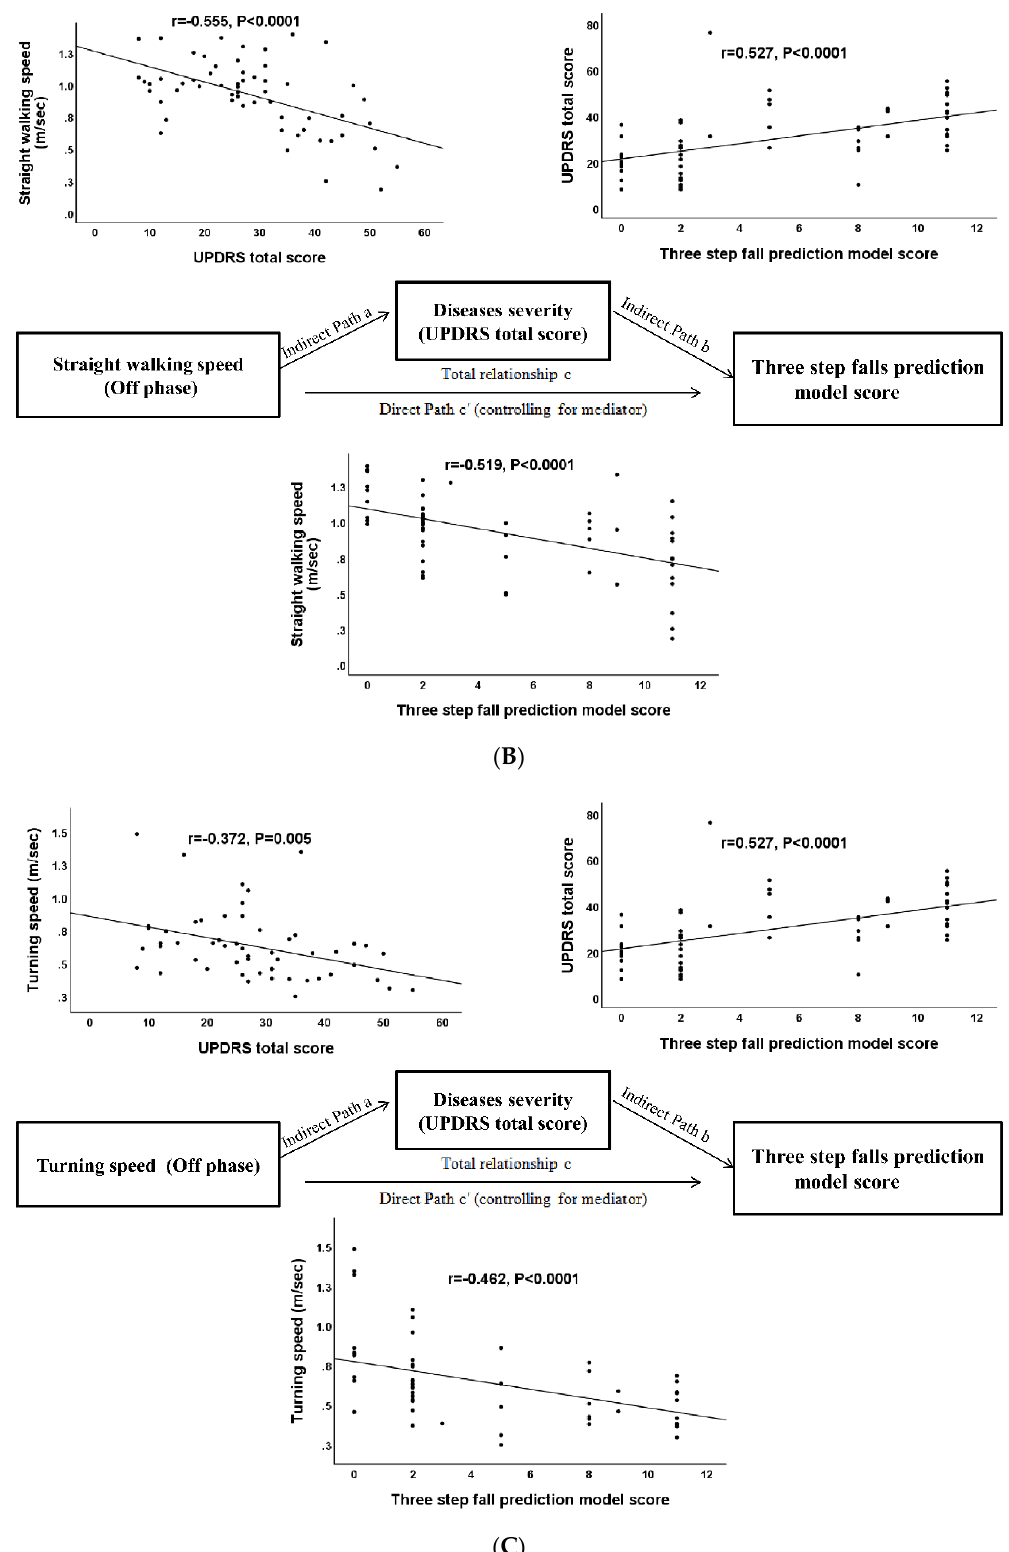
Figure 2. The diagram of the mediation hypothesis framework. The mediation analysis tests whether the direct effect of stride length ( A ), straight walking ( B ), and turning speed ( C ) (independent variables) on risk of falling (dependent variable) can be explained by the indirect influence of the UPDRS total score